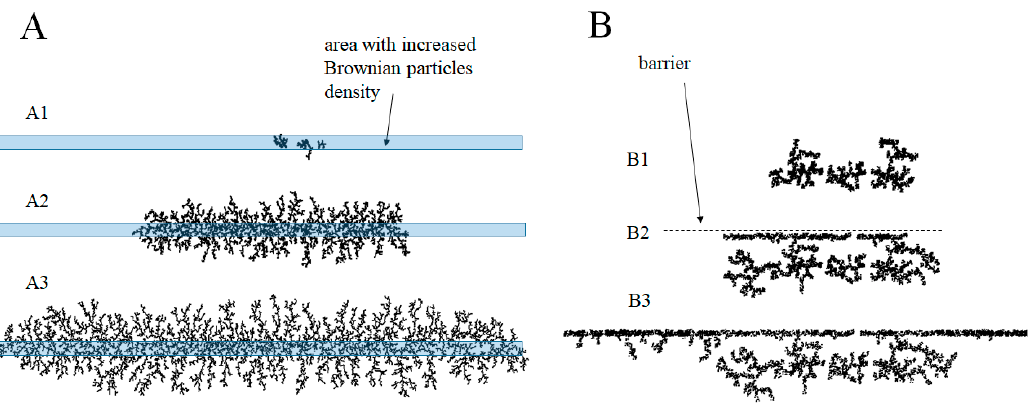
Figure 18. Simulation with DLA model. ( A ) The marked rectangular area has ten-fold density of Brownian particles compared to the rest of the area (time increases from A1 to A3). ( B ) Simulation with a barrier which mimics the presence of a fault. Time increases from B1 to B3.